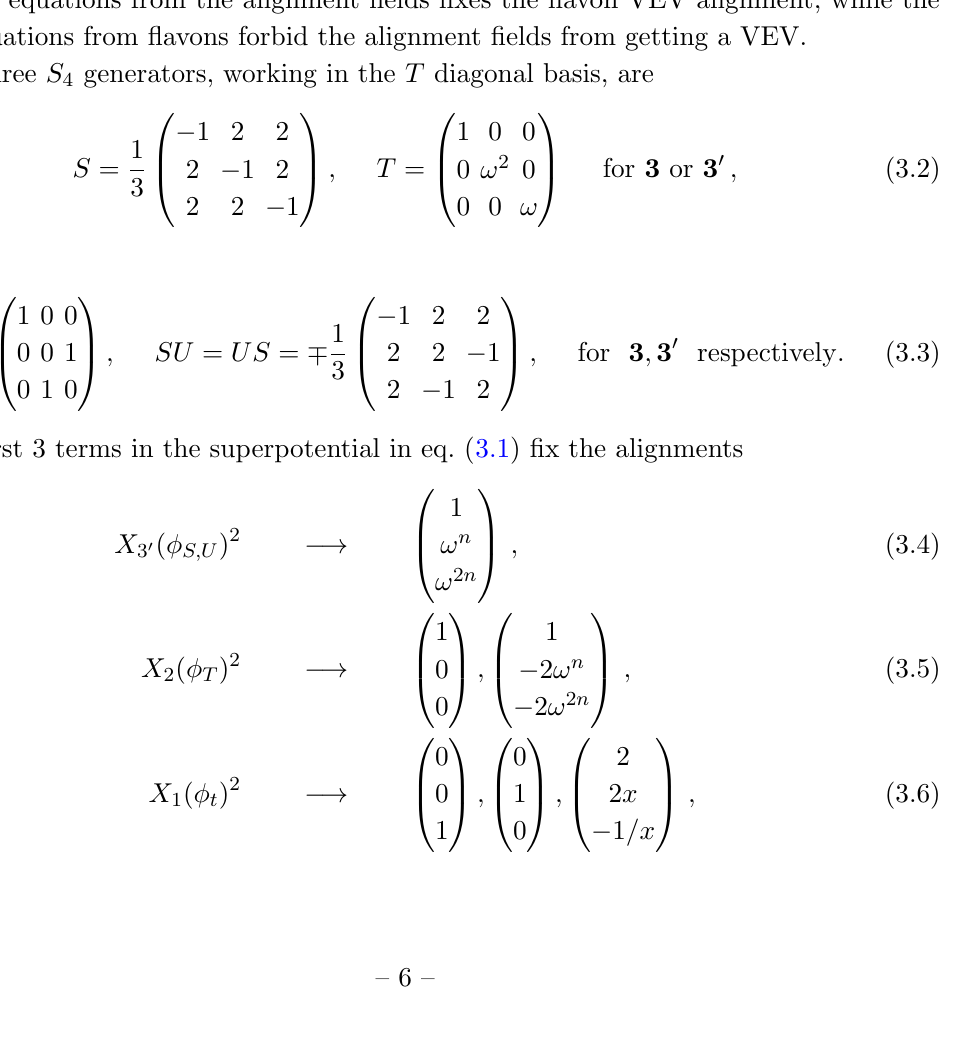
. These give the RH neutrino mass 16